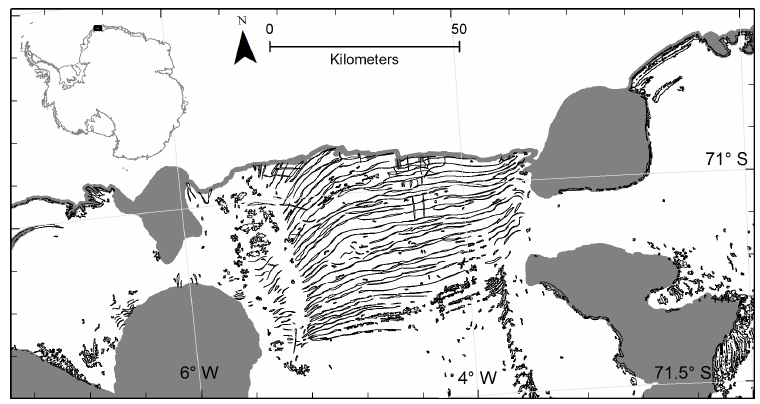
Figure 3. Map of parallel structures on Jelbart Ice Shelf front. In the upper left corner of the figure the location of the Jelbart Ice Shelf is shown. The grey lines represent the coastline taken from RAMP AMM-1 (http://bprc.osu.edu/rsl/radarsat/data/) and the grounded ice (grey areas) are taken from Haran et al . [23].